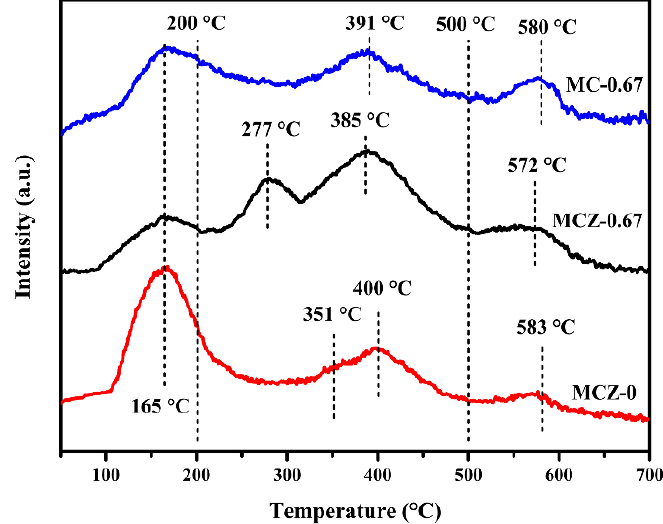
Figure 5. O 2 -temperature programmed desorption (O 2 -TPD) patterns of MCZ-0, MCZ-0.67 and MC-0.67 catalysts.